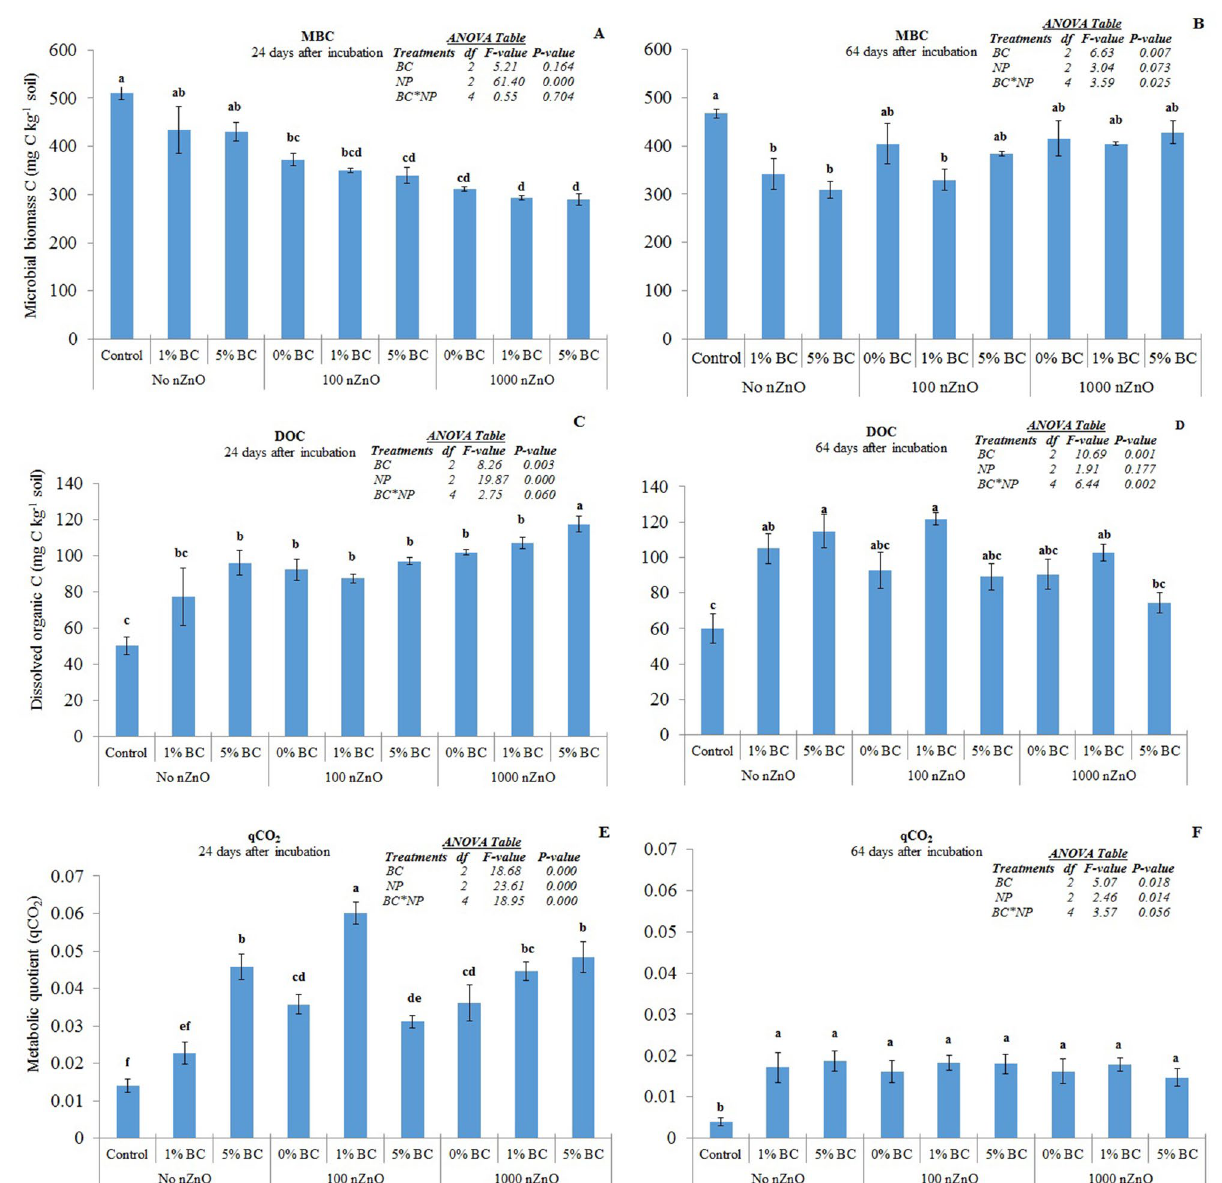
Figure 4. Microbial biomass C, dissolved organic C and metabolic quotient in response to nZnO and BC treatments after 24 (panels A , C , E respectively) and 64 days (panels B , C , F respectively). Different small letters on top of bars represent post-hoc HSD difference at 95% confidence interval. Error bars represent standard errors of means (n =